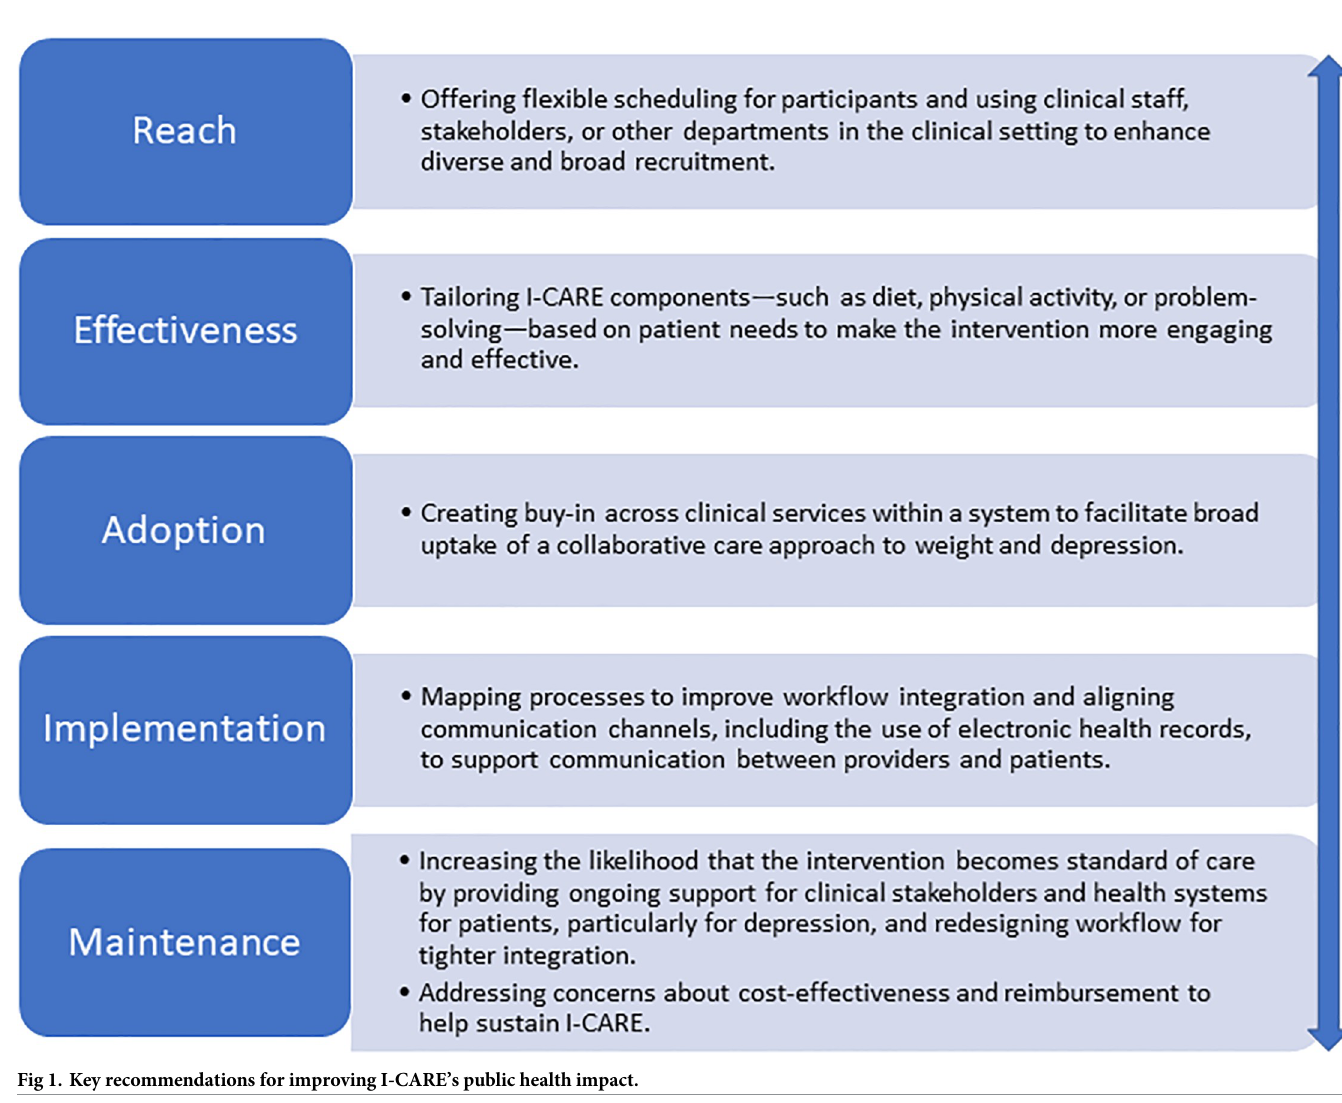
Fig 1. Key recommendations for improving I-CARE’s public health